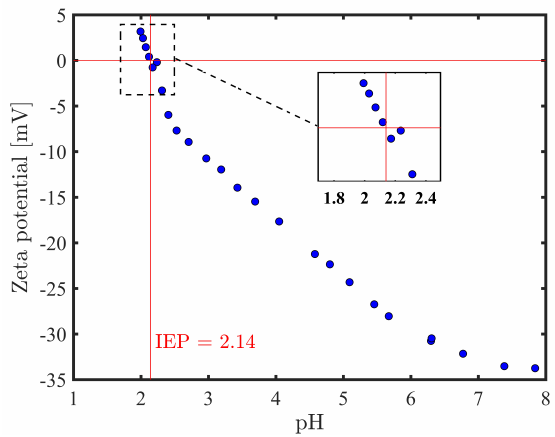
Figure 5. Zeta potential versus pH for UH004 P membrane without preservative agent.